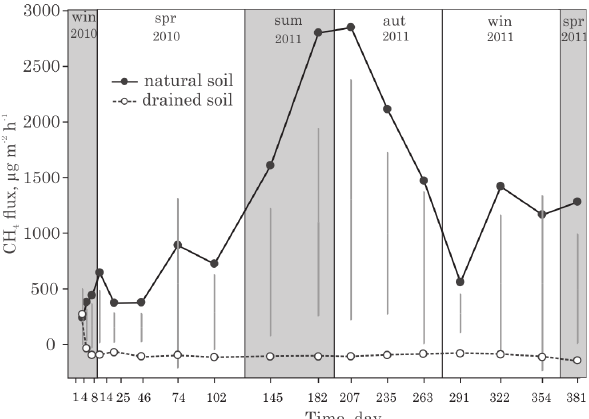
Figure 1. Methane (CH 4 ) flux from natural and drained Histosols with waterlogged grassland vegetation. Vertical bars represent the least significant difference by the Tukey test